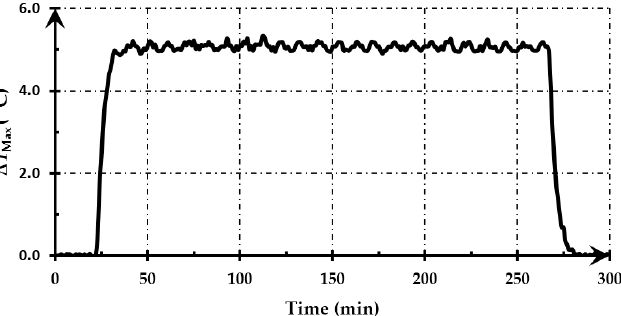
Figure 8. Maximum temperature increments Δ T Max of supercapacitors at voltage U = 2.7 V and current I = 1400 mA (nominal conditions).